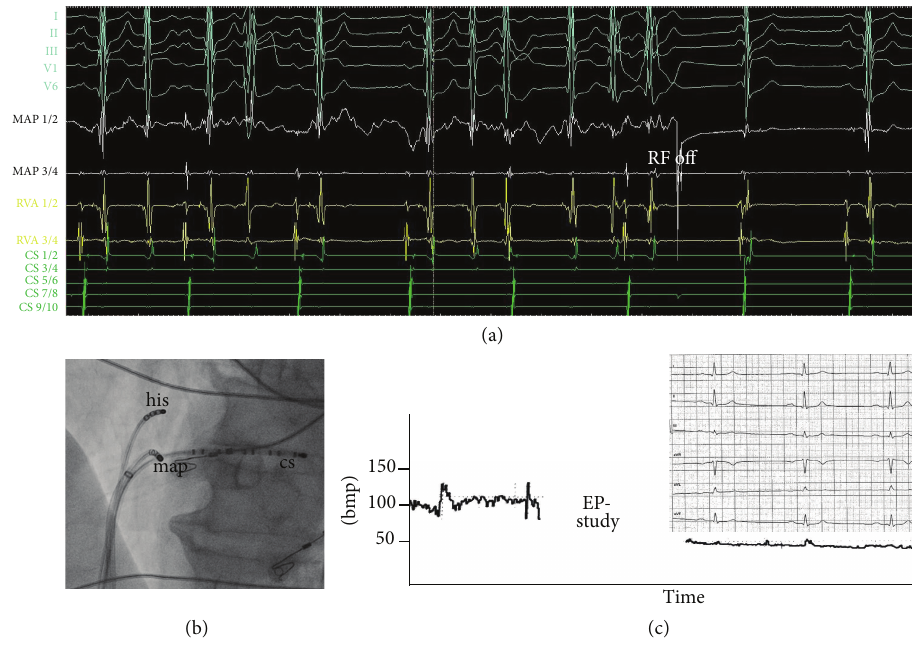
Figure 2: (a) Intracardiac electrocardiogram showing disappearance of the arrhythmia during ablation therapy with radiofrequency (RF). (b) Fluoroscopy (45 ∘ LAO) showing ablation catheter in slow-pathway position during ablation. (c) Drop in heart rate after successful ablation in continuous heart rate monitoring and postablation ECG showing normal sinus rhythm. ECG: electrocardiography, CS: coronary sinus, bmp: beats per minute, and RF: